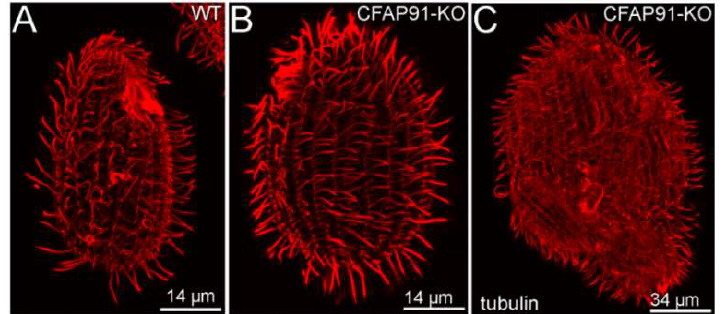
Figure 2. Cytokinesis defects in CFAP91-KO cells population. ( A – C ) Immunofluorescence images showing wild-type ( A ) and CFAP91-KO mutant ( B , C ) stained with a mix of anti-α-tubulin (12G10) and polyG antibodies to visualize the entire cilia length. ( B ) Note that CFAP91-KO cell (likely reverting from doublet stage) has a larger dimension than wild-type cell ( A ). ( C ) CFAP91-KO monster cell composed of several subcells formed due to defective cytokinesis.